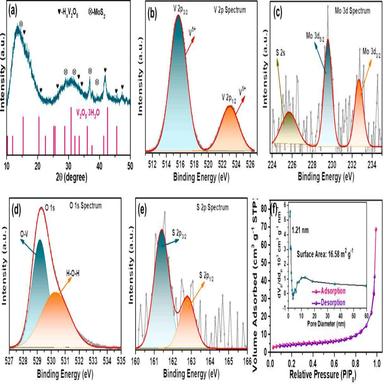
(a) XRD pattern of the V2O5@MoS2–2 NCs material. High-resolution XPS spectra of (b) V 2p, (c) Mo 3d, (d) O 1s, and (e) S 2p of the V2O5@MoS2–2 NCs material. (f) N2 adsorption-desorption isotherm and the pore size distribution profile (inset) of the V2O5@MoS2–2 NCs material.